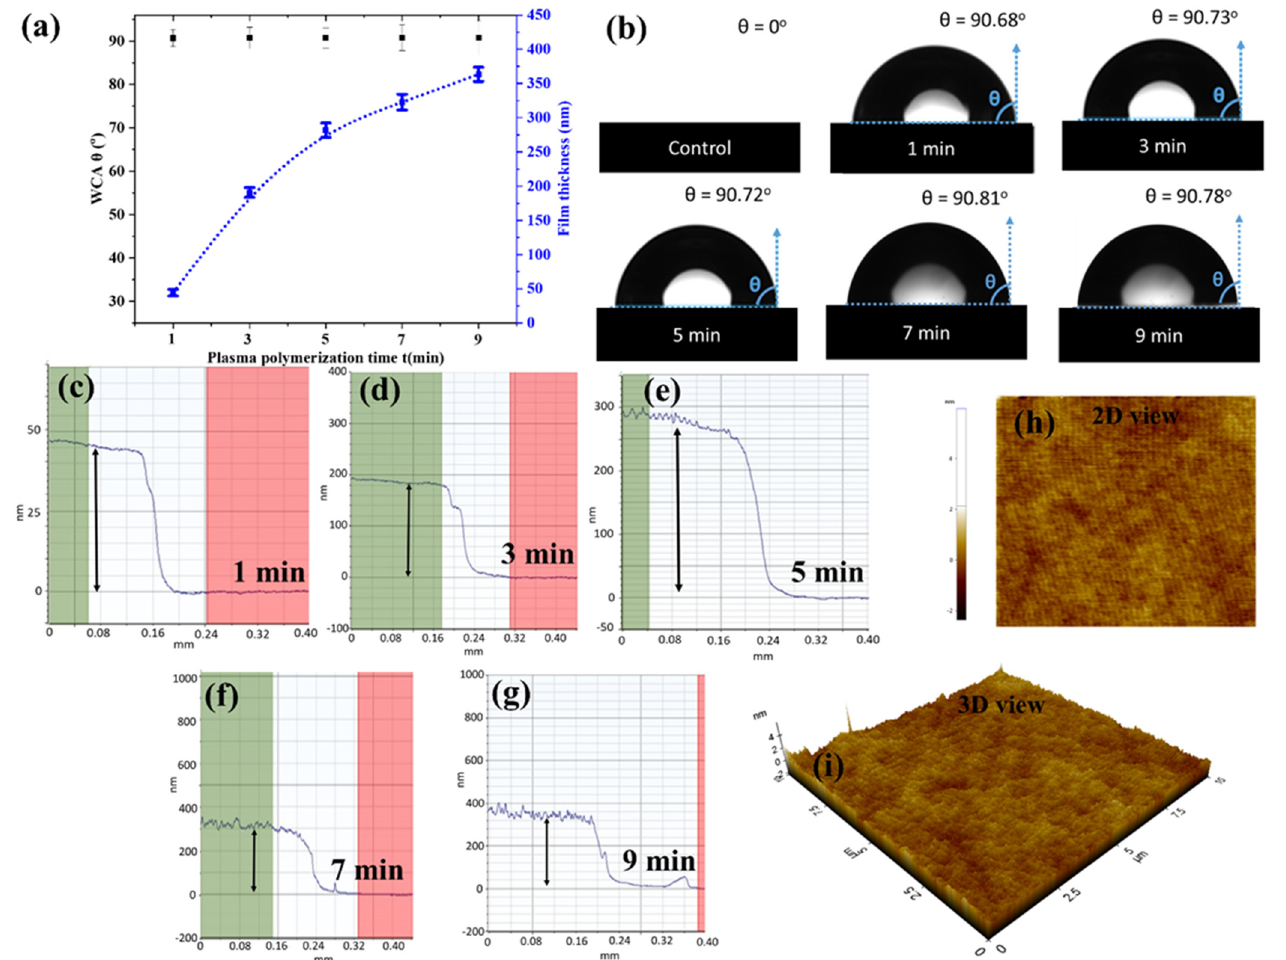
Figure 2. ( a ) Average static WCA and film thickness at different plasma polymerisation times. ( b ) Photographs of WCA of control and AP − PP − lim samples at different plasma polymerisation times. ( c – g ) Step height measurements of AP − PP − lim films at different plasma polymerisation times with their corresponding height profile plots. ( h , i ) 2D and 3D AFM profiles of the smooth AP − PP − lim nano-thin films deposited at 1 min.